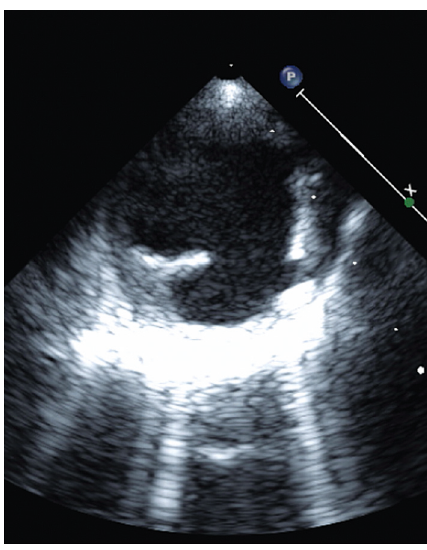
Figure 1: Short-axis TEE view of atheromatous aortic plaque.